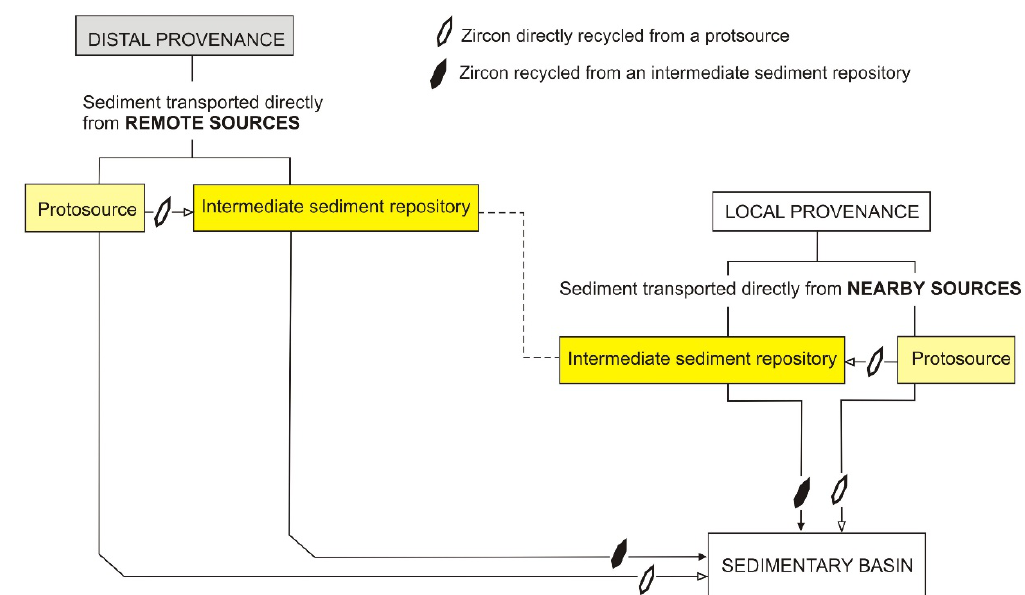
Figure 1. Schematic diagram illustrating the interplay between distal and local provenance, remote and nearby sources, protosources, and intermediate sediment repositories (ISRs).